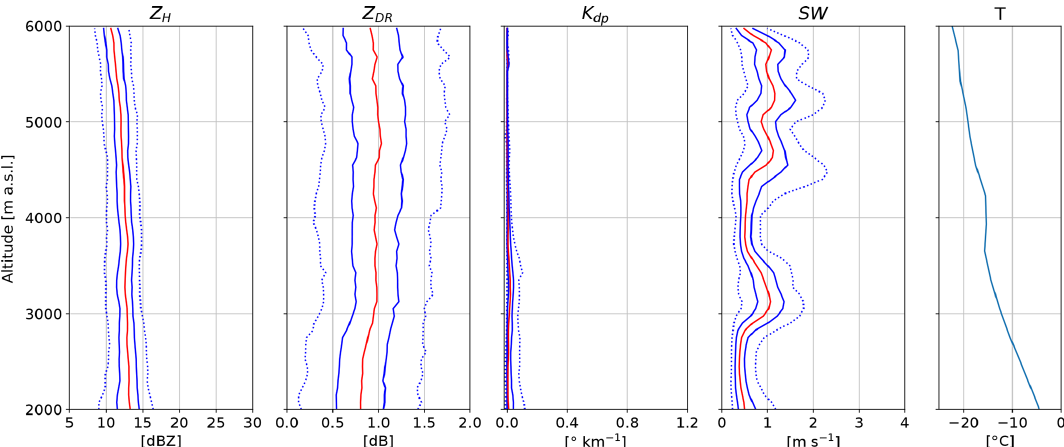
Figure 7. Vertical profiles of quantiles of Z H , Z DR , K dp and SW from MXPol from 03:00 to 04:00UTC on 28 February 2018. The red line shows the median, while the solid blue lines show the 25th and 75th percentiles and the dotted blue lines the 5th and 95th percentiles. The statistics are based on 11 RHIs towards the MHS site. The data within a horizontal distance of 7 to 20km from MXPol are selected.